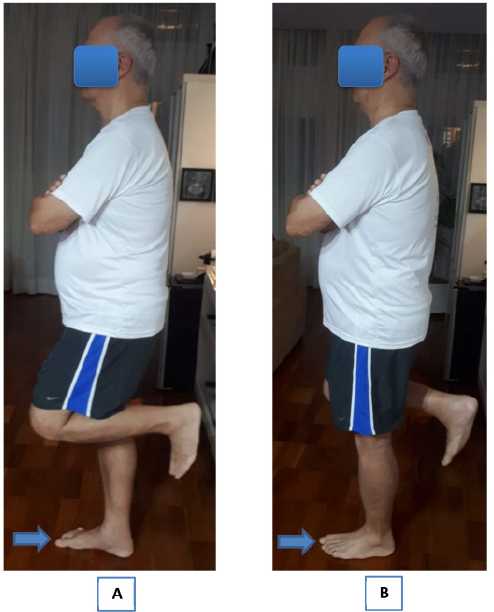
Figure 5. The individual is in single-legged stance with the right ( A ) or with the left ( B ) leg as the arrows